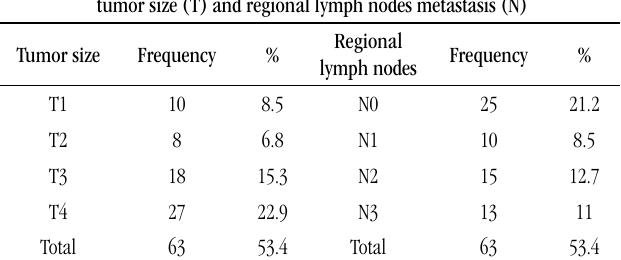
tABLE 1 – Frequency and percentage of patients with surgically resected gastric cancer divided according to tumor size (T) and regional lymph nodes metastasis (N) Tumor size